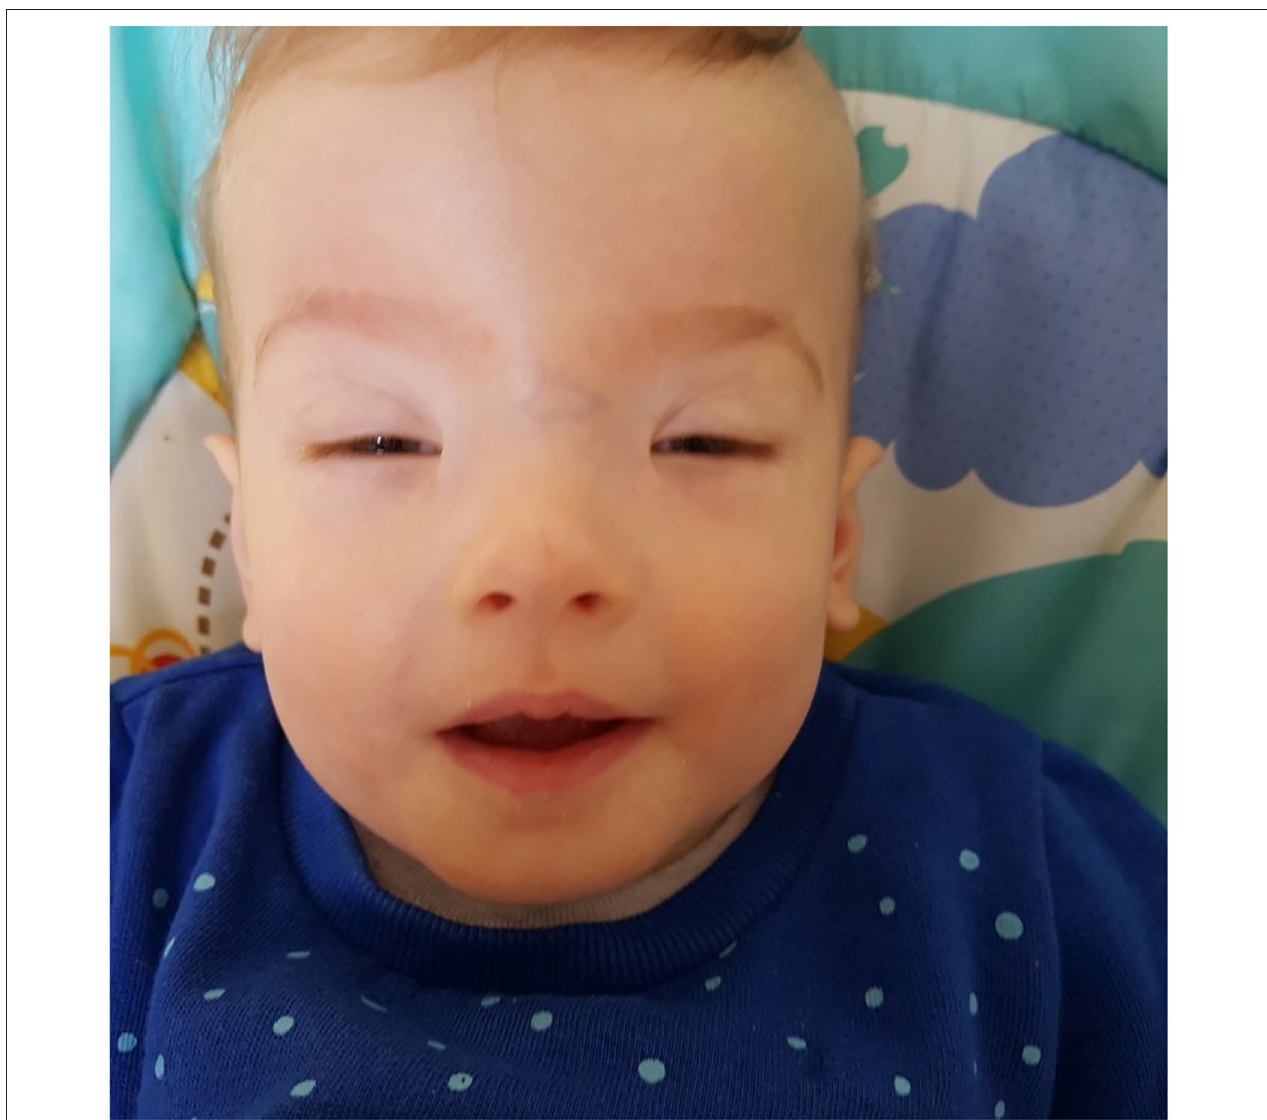
FIGURE 1 | The facial phenotype of Case 1 at 11 months. Note the significant short palpebral fissures, ptosis, epicanthic folds and high forehead with flat, broad nasal bridge.